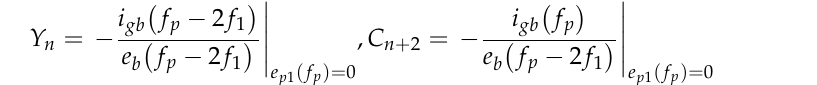
Table 1. Parameters of MMC in the downscaled prototype.